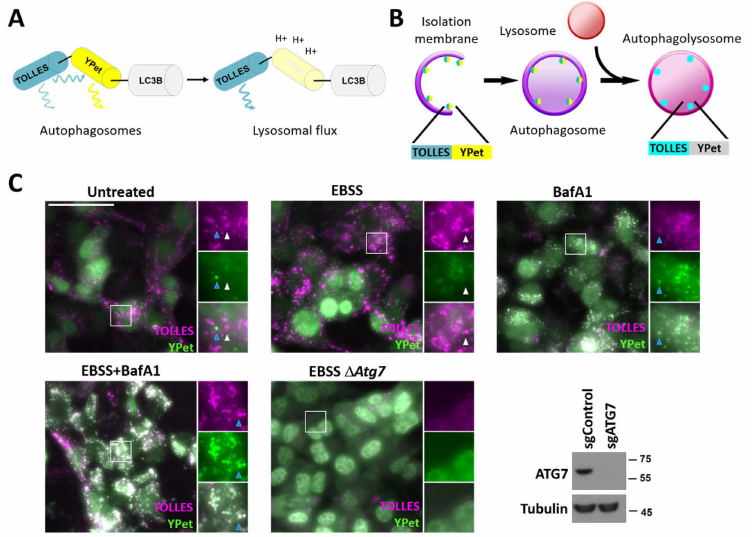
Figure 1. Characterization of SRAI as a reporter to observe bulk autophagic flux. ( A ) Schematic of the expected fluorescence profile of SRAI (TOLLES-YPet)-LC3B within different compartments (representing TOLLES as a FRET donor and YPet as a FRET acceptor). TOLLES is represented in blue and YPet in yellow or faint yellow if quenched. ( B ) SRAI-LC3B reporter localizes in phagophores and autophagosomes and TOLLES and YPet fluorescence is observed. However, after lysosomal fusion, the YPet is quenched and only TOLLES fluorescence is visible. ( C ) Imaging-based autophagic flux assay in SRAI-LC3B PDAC cells (transfected with sgControl or sg Atg7 ) in full nutrients (untreated) or following 4 h starvation (EBSS) in the presence or absence of BafA1 (50 nM, 4 h). Representative immunofluorescence images of TOLLES (magenta) and YPet (green); white arrows show examples of TOLLES-positive and YPet-negative puncta and blue arrows indicate TOLLES and YPet-positive puncta. Bar = 50 µ m. On the bottom right, immunoblot showing ATG7 levels in CRISPR knockout ∆ Atg7 PDAC cells in comparison to